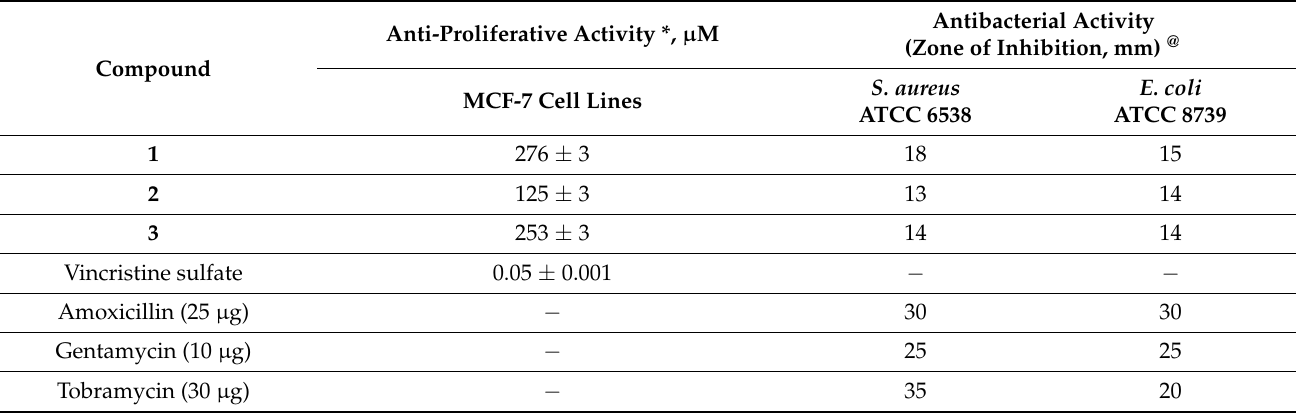
Antibacterial Activity (Zone of Inhibition, mm) @